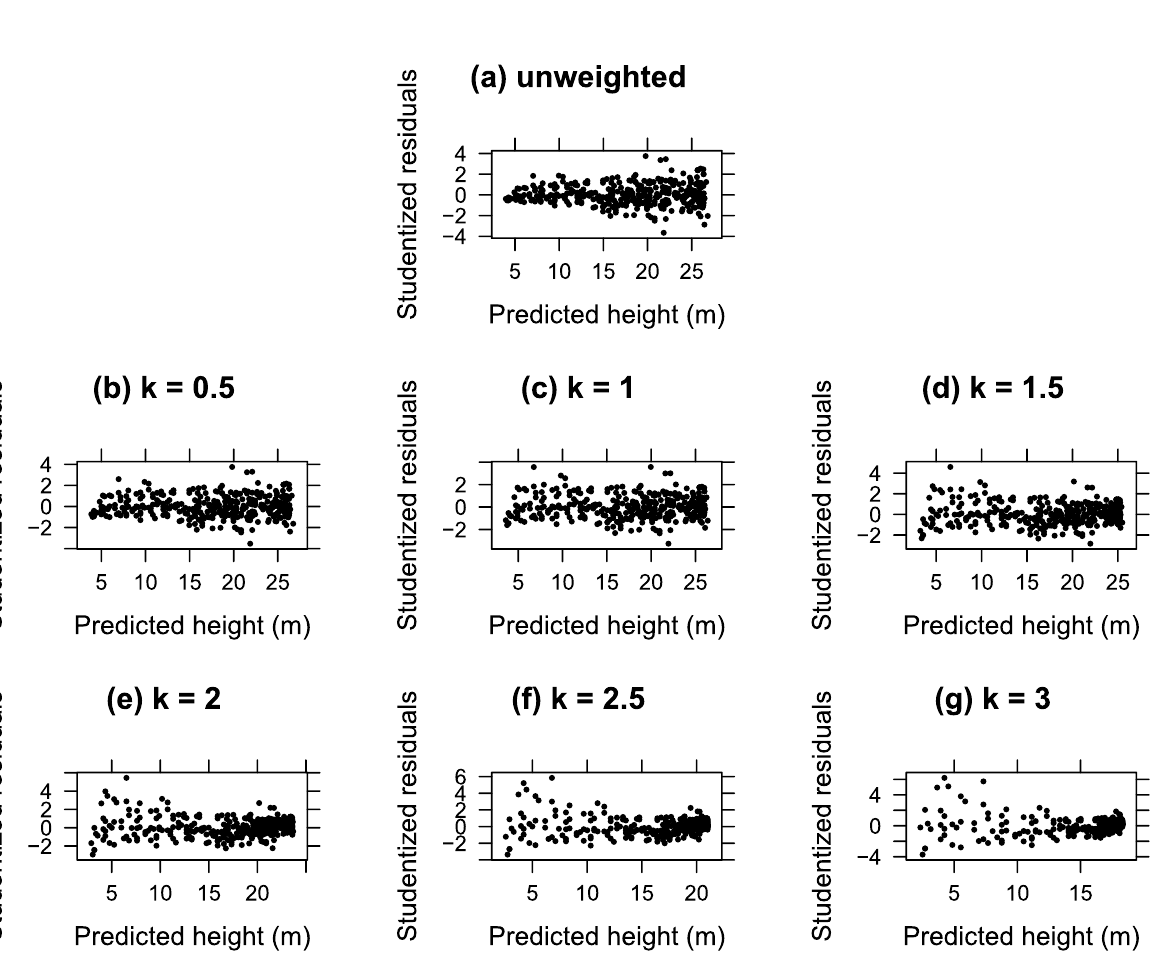
Fig. 10 The plot of studentized residuals against the predicted height for A. araucana . The studentized residuals were obtained by fitting model SM12 AA ( a ) without weighting, with weight w i = 1 ∕ DBH k i , where ( b ) k